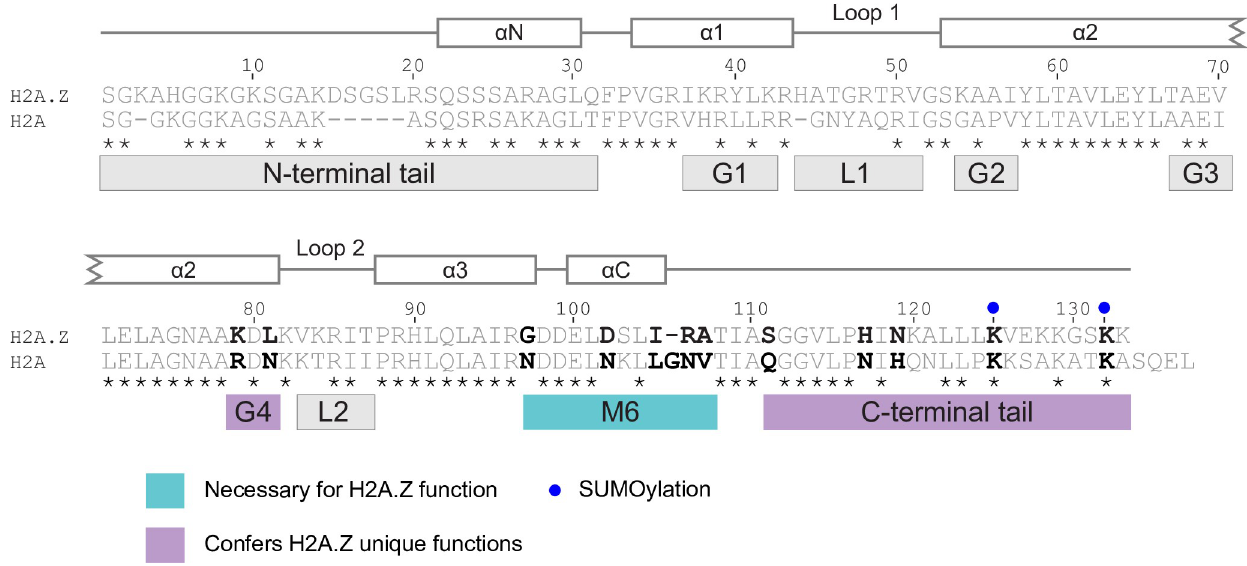
Fig 8. The M6, G4, and C-terminal regions of H2A.Z contributed to its unique function and distinguished it from H2A. Schematic of H2A.Z and H2A proteins highlighting the M6, G4, and C-terminal regions as key contributors to H2A.Z unique identity. The M6 region is necessary for H2A.Z function, while the G4 and C-terminal regions confer H2A.Z unique functions when combined with M6. Within these regions, amino acids that deviate between H2A.Z and H2A and that have been individually implicated in H2A.Z activities, by this study or previous literature, are highlighted in bold.